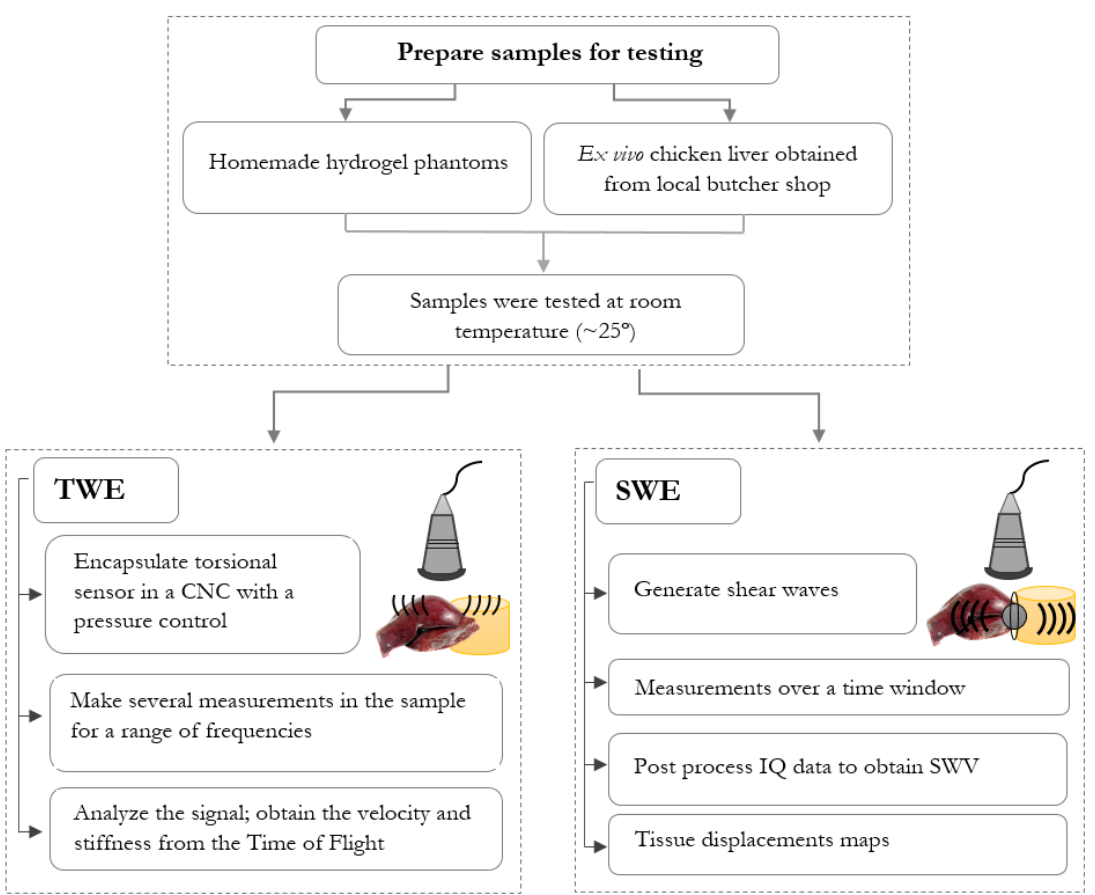
Figure 1. Flow chart showing the steps for scans performed with both techniques, Torsional Wave Elastography (TWE) and Shear Wave Elastography Imaging